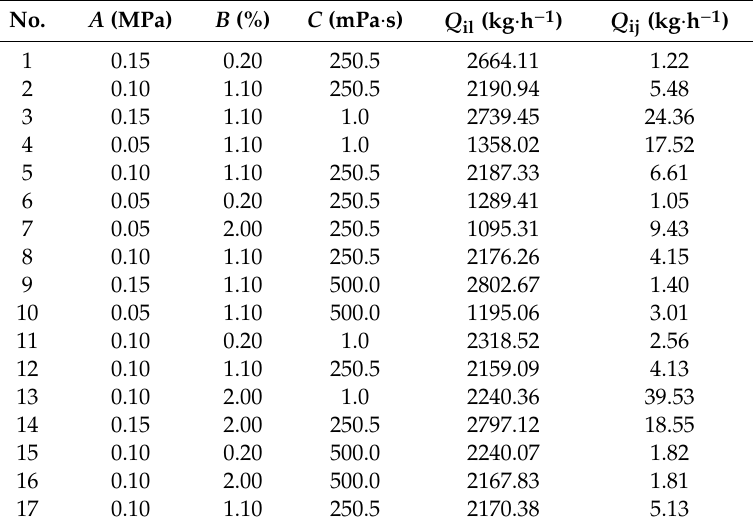
Table 3. Response surface experimental design and